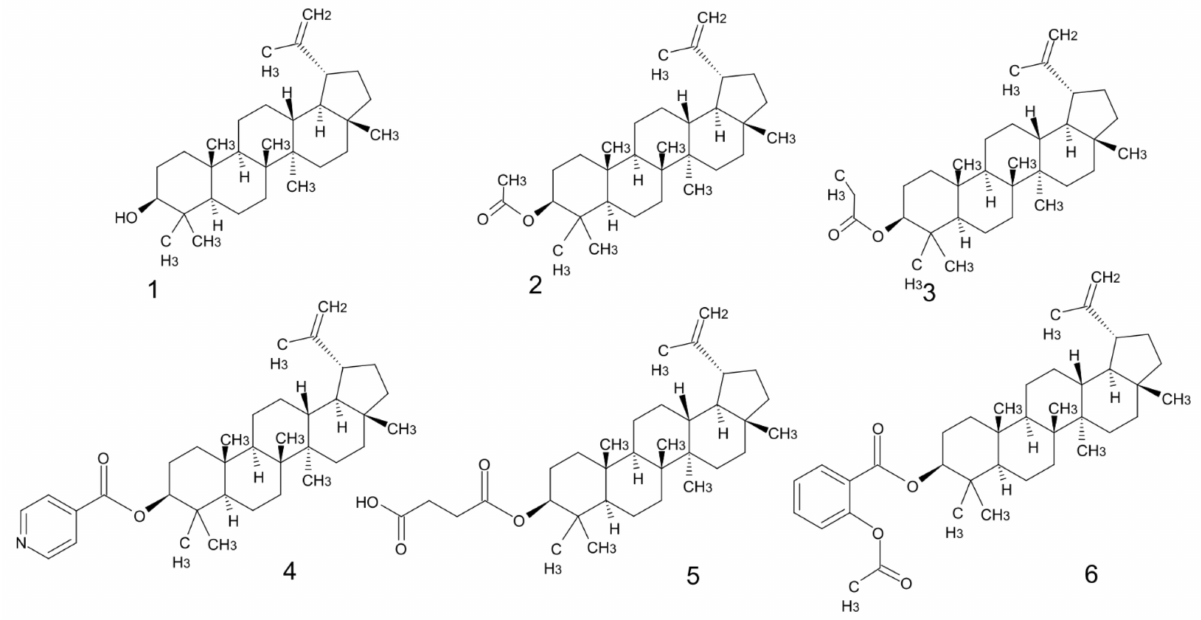
Figure 1. The structures of lupeol and its new derivatives ( 1 : lupeol, 2 : lupeol acetate, 3 : lupeol propionate, 4 : lupeol isonicotinate, 5 : lupeol succinate, 6 : lupeol